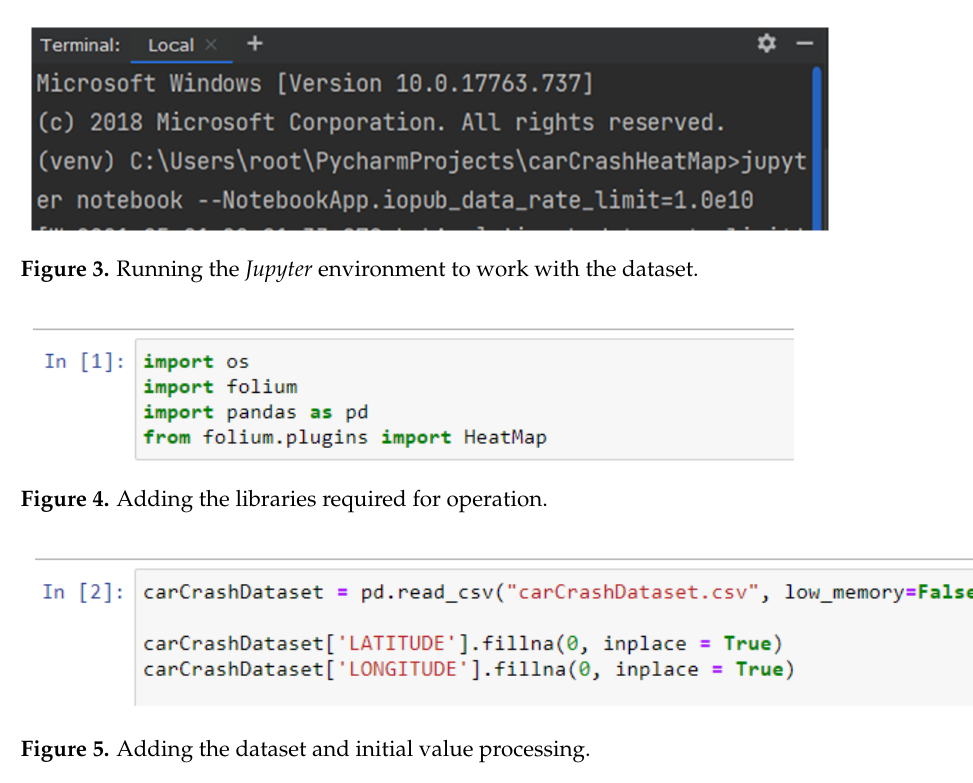
Figure 2. Description of the employed dataset.